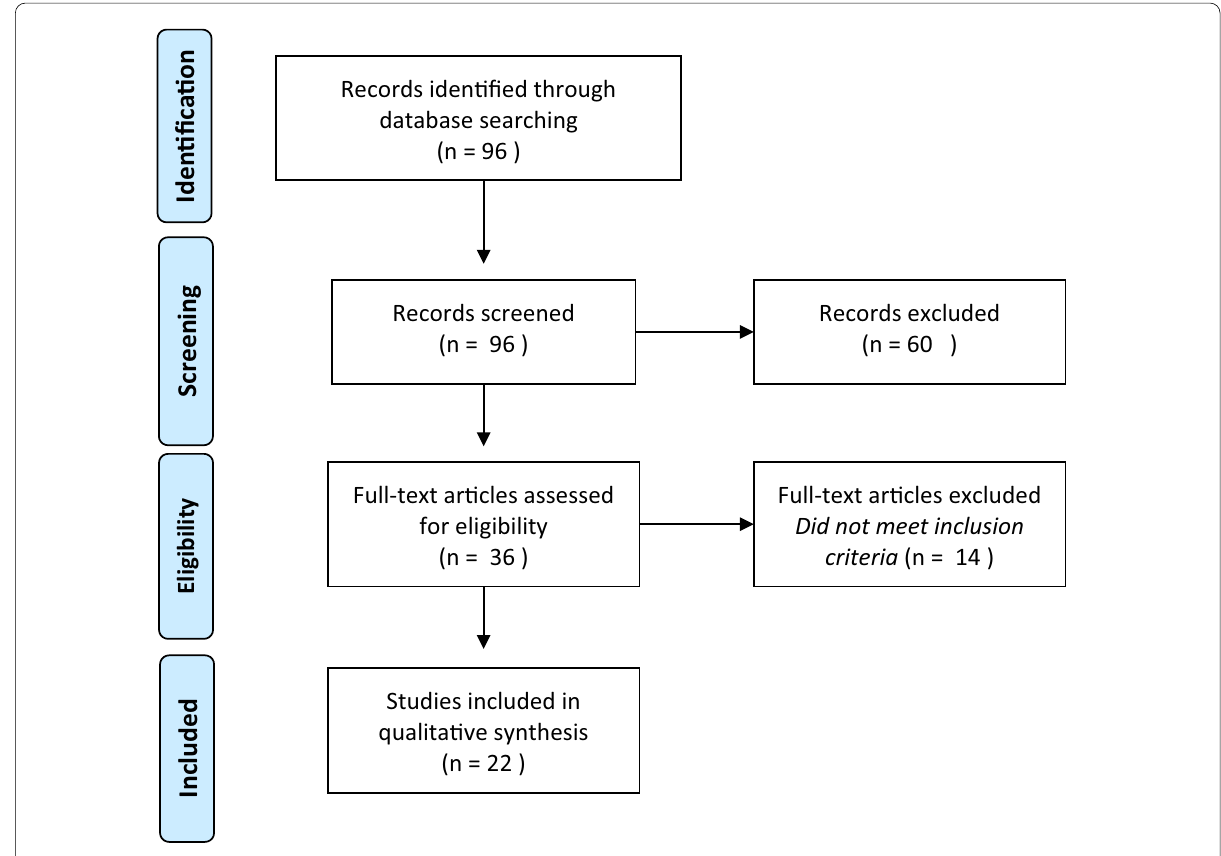
Fig. 1 PRISMA systematic review flow